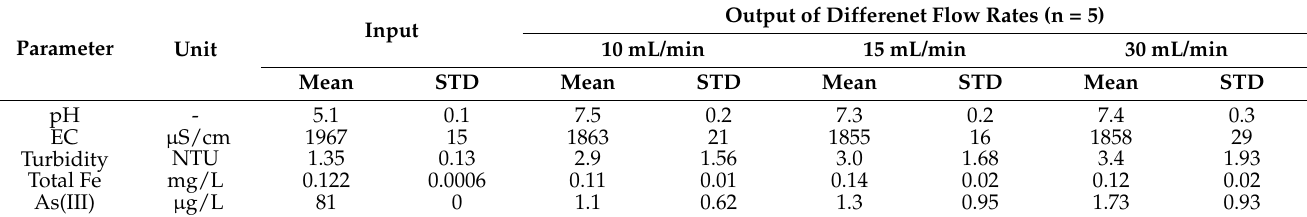
Table 3. Influent and effluent As concentration in the column experiment.